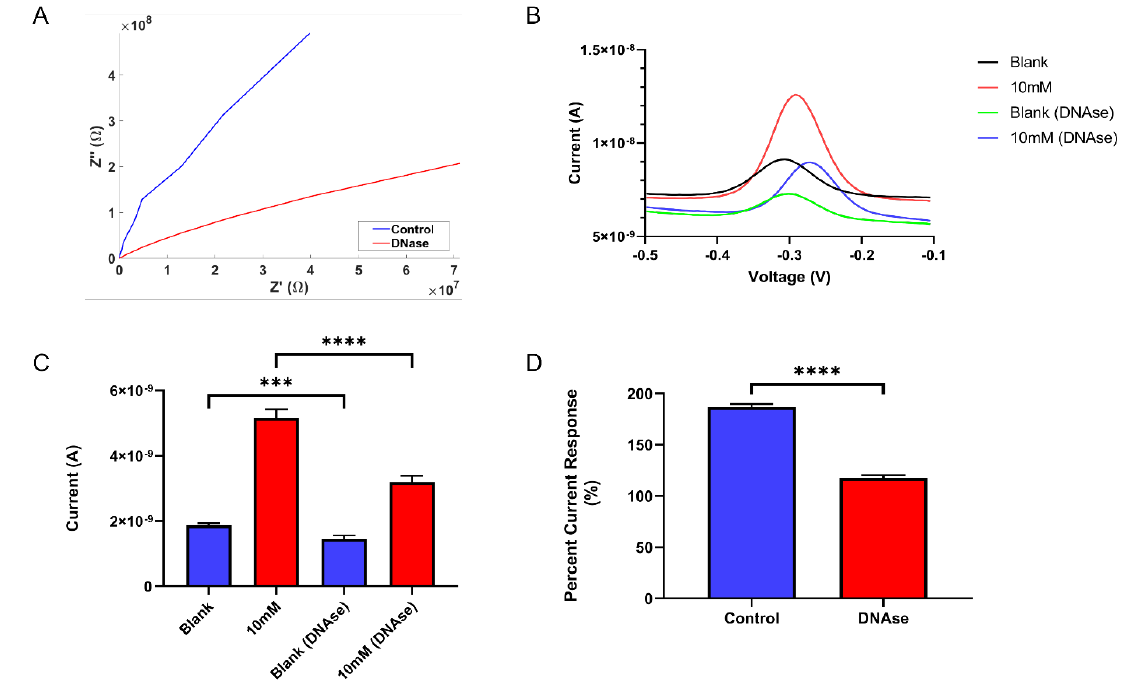
Figure 3. In vitro DNase exposure test. The aptasensors’ performance was compared before and after exposure to DNase-1. ( A ) Nyquist plot of sensors before and after DNase-1 exposure. Sensors became more resistive after DNase-1 exposure. ( B ) SWV waveform of sensors before and after DNase-1 exposure. A decrease in background current and MB reduction peak size can be seen. ( C ) Quantification of peak current. A significant amplitude decrease is observed for both blank and 10 mM cocaine response after exposure to DNase-1. One-way ANOVA, n = 8. ( D ) Percent current re- sponse characterization. The sensor’s s ensitivity towards cocaine significantly decreased after being